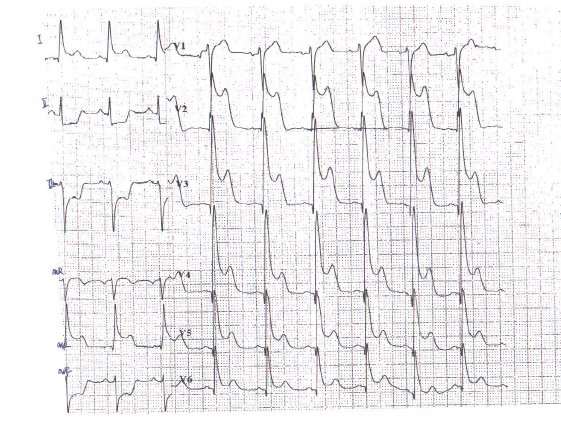
Figure 4: ECG record of 16 minutes after attack at 5:58 a.m. on August 4, 2013.